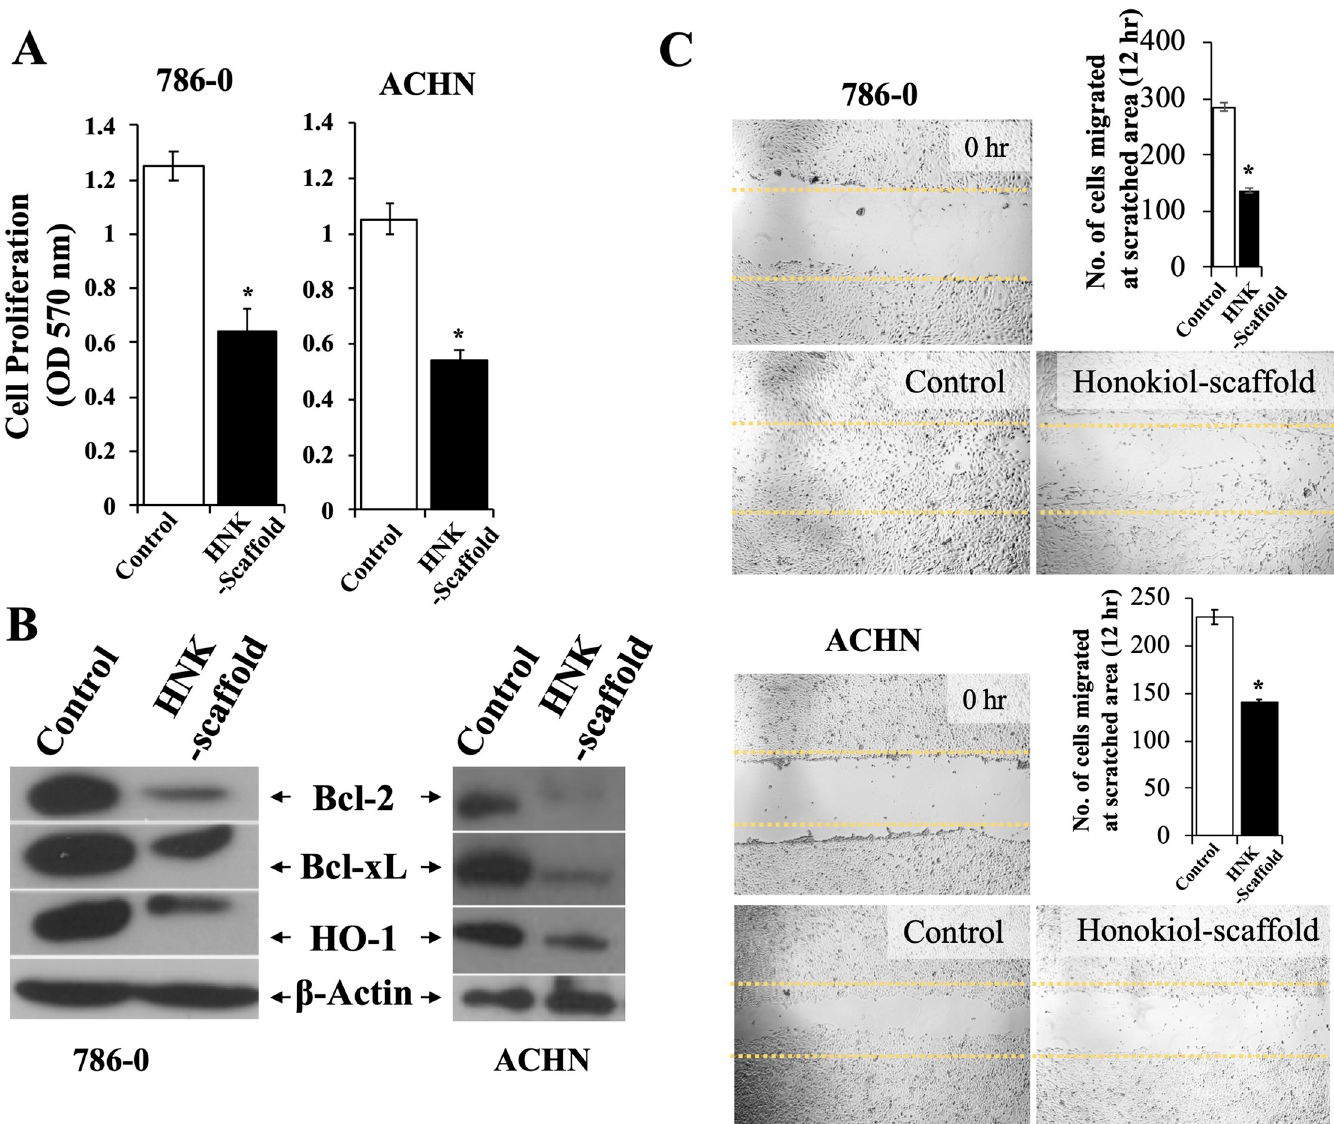
Fig 4. Biological activities of Honokiol released from Honokiol-loaded PLGA 85–15 scaffold. (A) Renal cancer cells (786–0 and ACHN) were treated with either 0.5x0.5 cm 2 Honokiol-loaded PLGA 85–15 scaffold or control scaffold for 24 hr. Following treatment, cell proliferation was measured by MTT assay and (B) cell lysates were prepared after 24 hr treatment and the expression levels of Bcl-2, Bcl-xL, HO-1 and β -actin were analyzed by Western blotting. (C) “Wound healing assay”, as described in the “Methods” section was performed using 786–0 and ACHN cells to assess the migration of renal cancer cells. Briefly, cells were treated with either Honokiol-loaded PLGA 85–15 scaffold or control after scratching the diameter of the culture well with a 200 μ l pipette tip to simulate a wound. To assess wound closure, the phase contrast microscope photographs of the wound area at 0 hr and after 12 hr treatment, were analyzed. The bar graph represents the quantification of number of cells migrated to the wound area. B, and C results shown are representative of three independent experiments. A-C, the columns in the bar graphs represent the mean ± S.D. of experimental readings. � , represents p < 0.05 compared with respective controls.